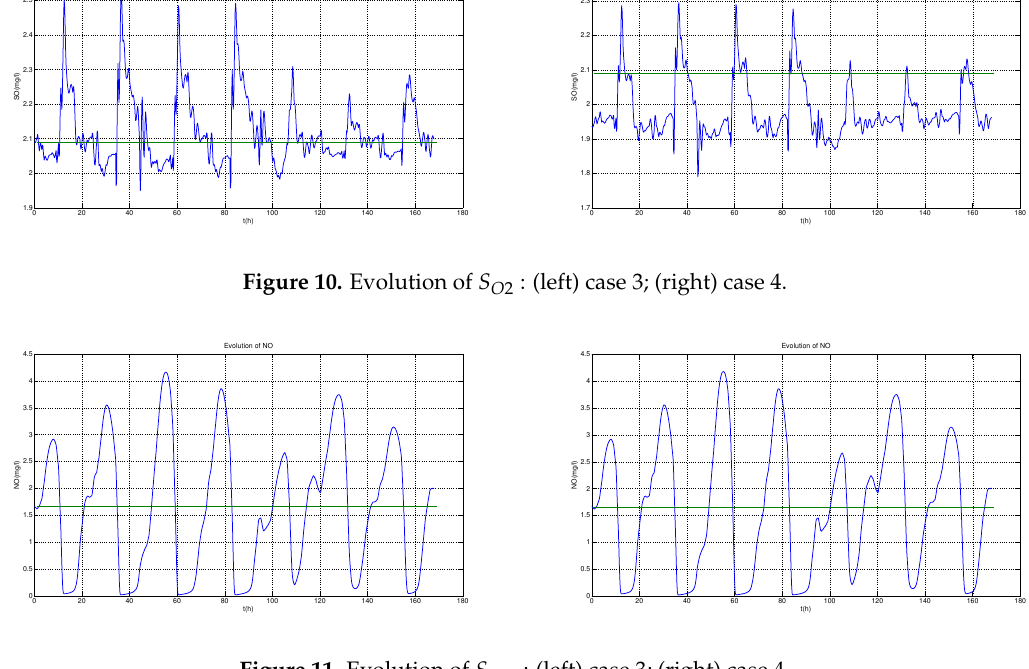
Figure 11. Evolution of S NO : (left) case 3; (right) case